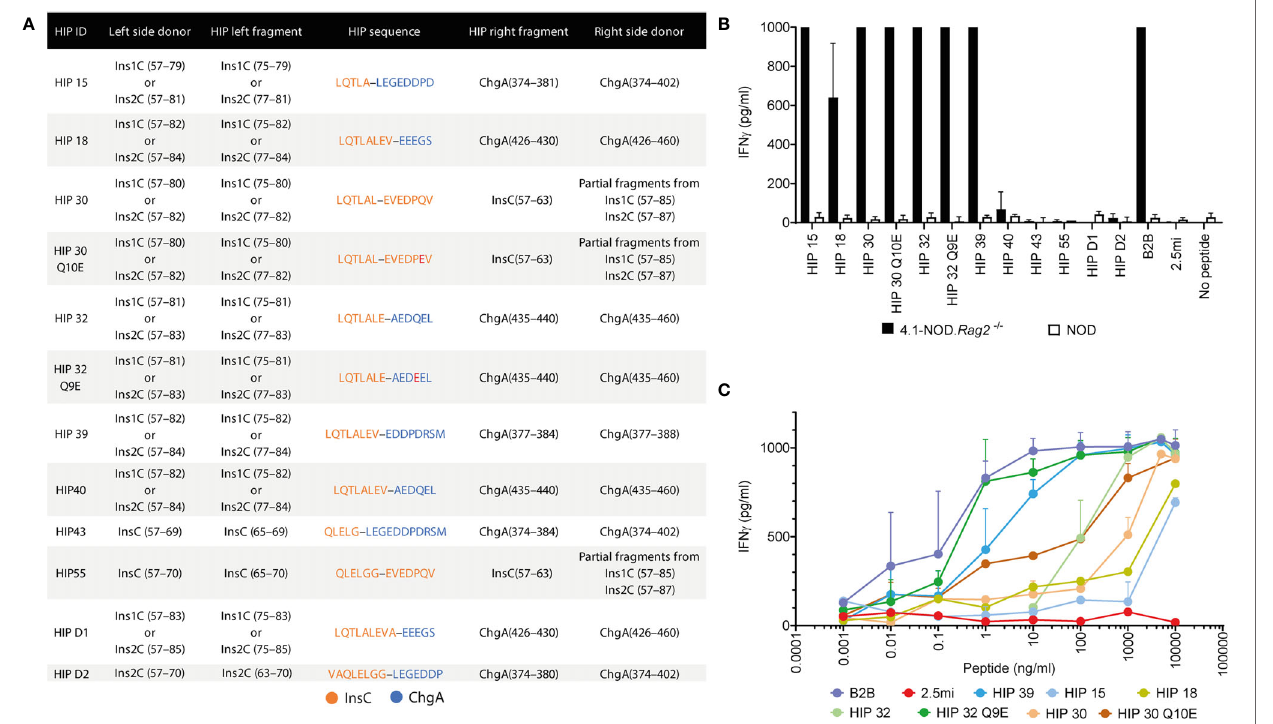
FIGURE 4 | Using the B2B motif to identify 4.1-TCR ligands. (A) Table depicting the right and left sequence of 13 HIP candidates conforming to the B2B ’ s 4.1-TCR contact motif. The residue numbers on the left- and right-side donors refer to the full-length, extended polypeptide donors. The third and fi fth columns indicate the residues from each donor contributing to HIP epitope formation. The fourth column provides the amino acid sequence of each HIP, with hyphens delineating the HIP junctions. (B) Anti-CD3/CD28 mAb-expanded splenic CD4+ T cells from 4.1-NOD. Rag2 – / – or NOD mice were co-cultured with syngeneic NOD splenocytes as APCs in the presence or absence of the different HIPs or the BDC2.5mi mimotope as a negative control (all at 10 m g/ml). Forty-eight hours later, supernatants were harvested and the IFN g content measured by ELISA ( n = 3). (C) Responsiveness of the cells from (B) to the different HIPs over a broad range of peptide concentrations (0.001 ng/ml to 10 m